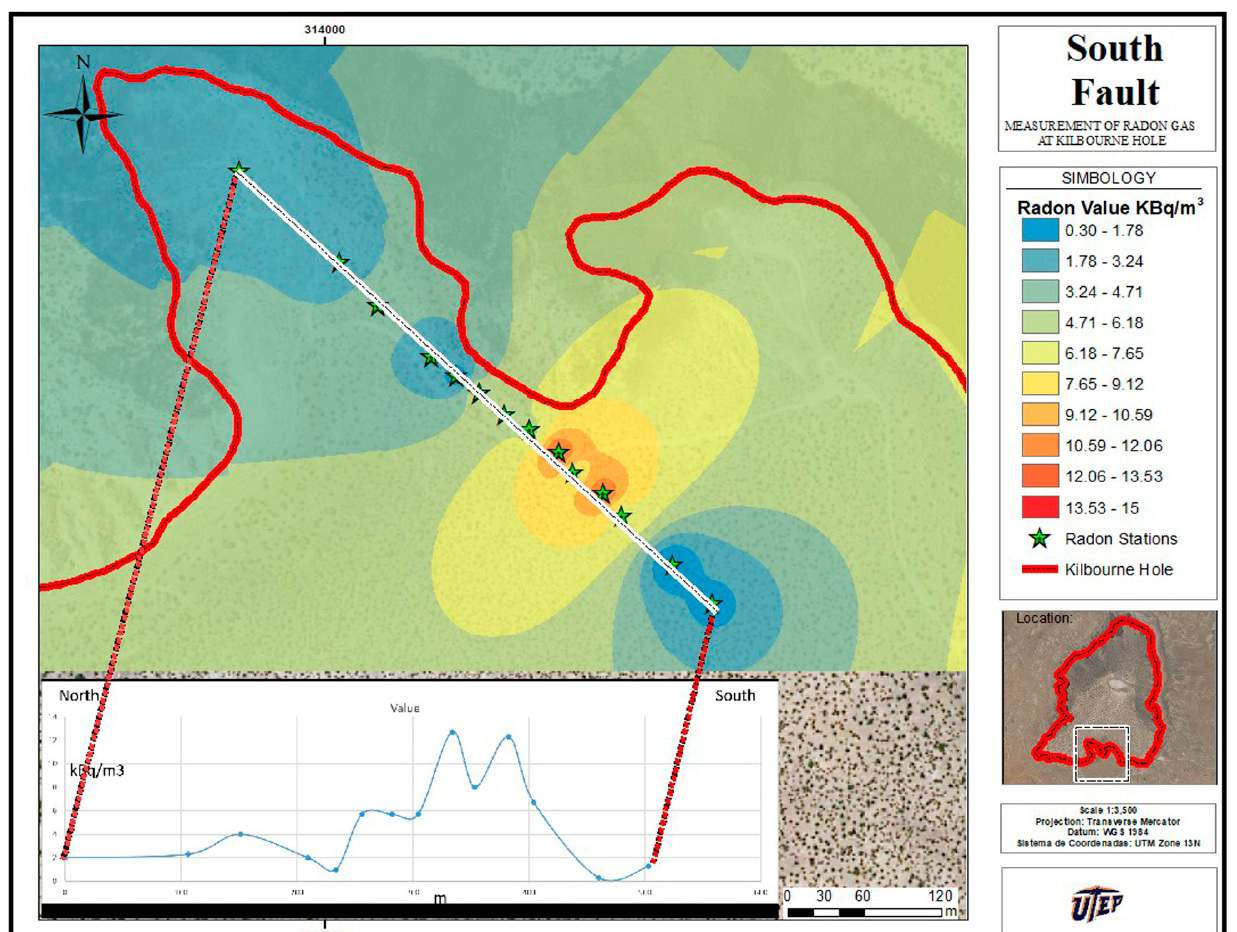
Figure 4. Soil Rn gas was measured along a transect across an inactive fault at Kilbourne Hole, south of the crater. To show the values departing from the average, measurements were taken at given space intervals. The corresponding curve is reported to provide insight into the anomaly.